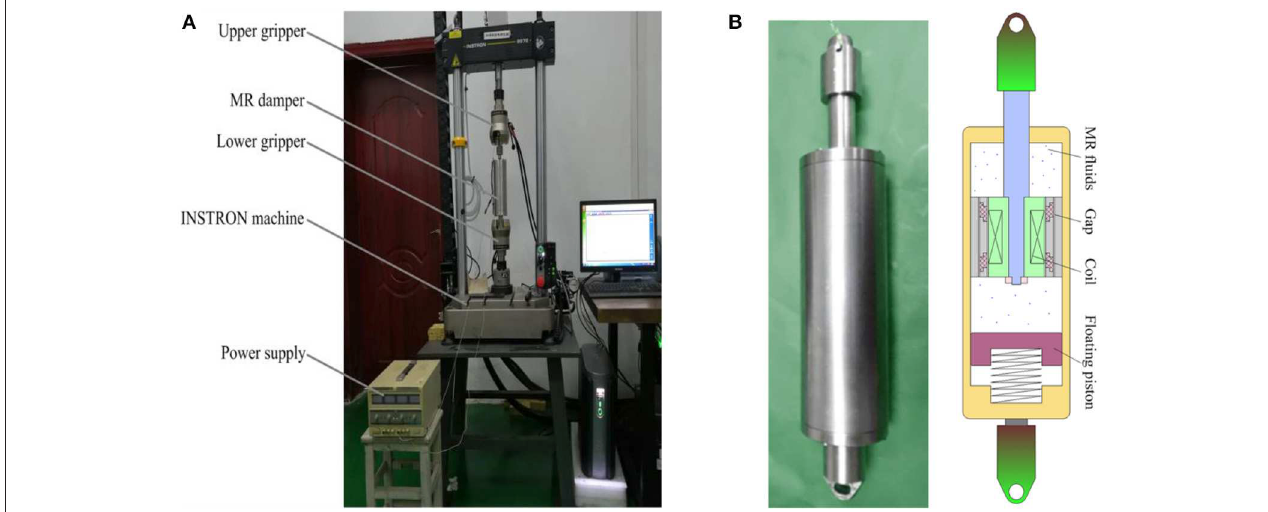
FIGURE 1 | Mechanical test system. (A) Tensile machine. (B) MR damper used for testing.